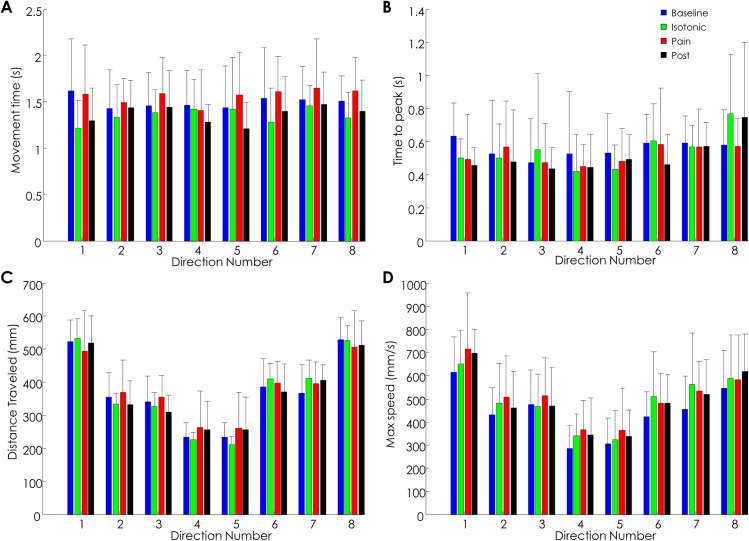
Kinematic data.Mean and standard deviation of the kinematic variables. A. movement duration; B. time to reach the peak speed; C. distance traveled; D. maximal speed. The distance traveled and maximal speed were modulated according to the biomechanical constraints of aiming in different directions; the movement duration and time to peak were invariant with respect to the combination of directions and conditions. Refer to Fig 1 for definition of the movement directions.